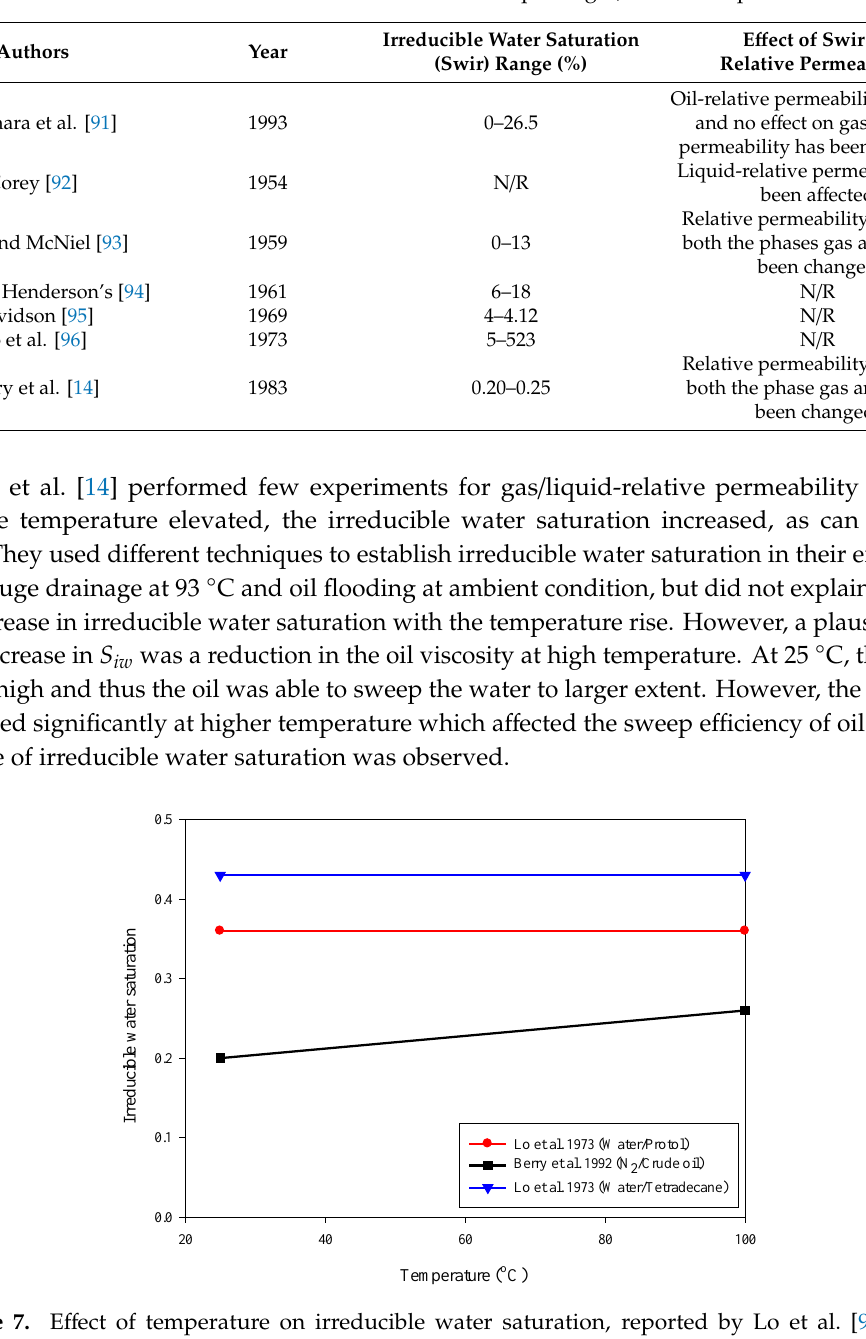
Table 5. E ff ect of irreducible water saturation on two-phase gas / oil-relative permeabilities.